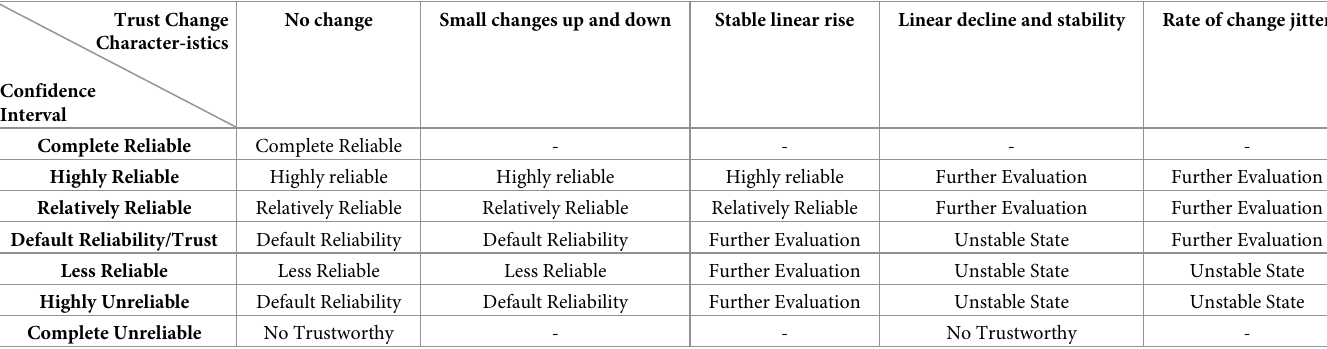
Table 3. Trust evaluation form after introducing rate of